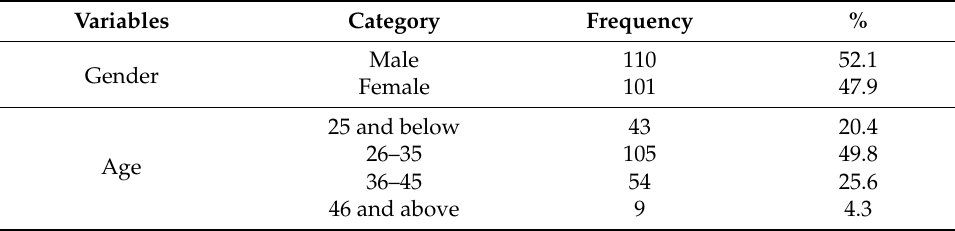
Table 1. Demographic characteristics of